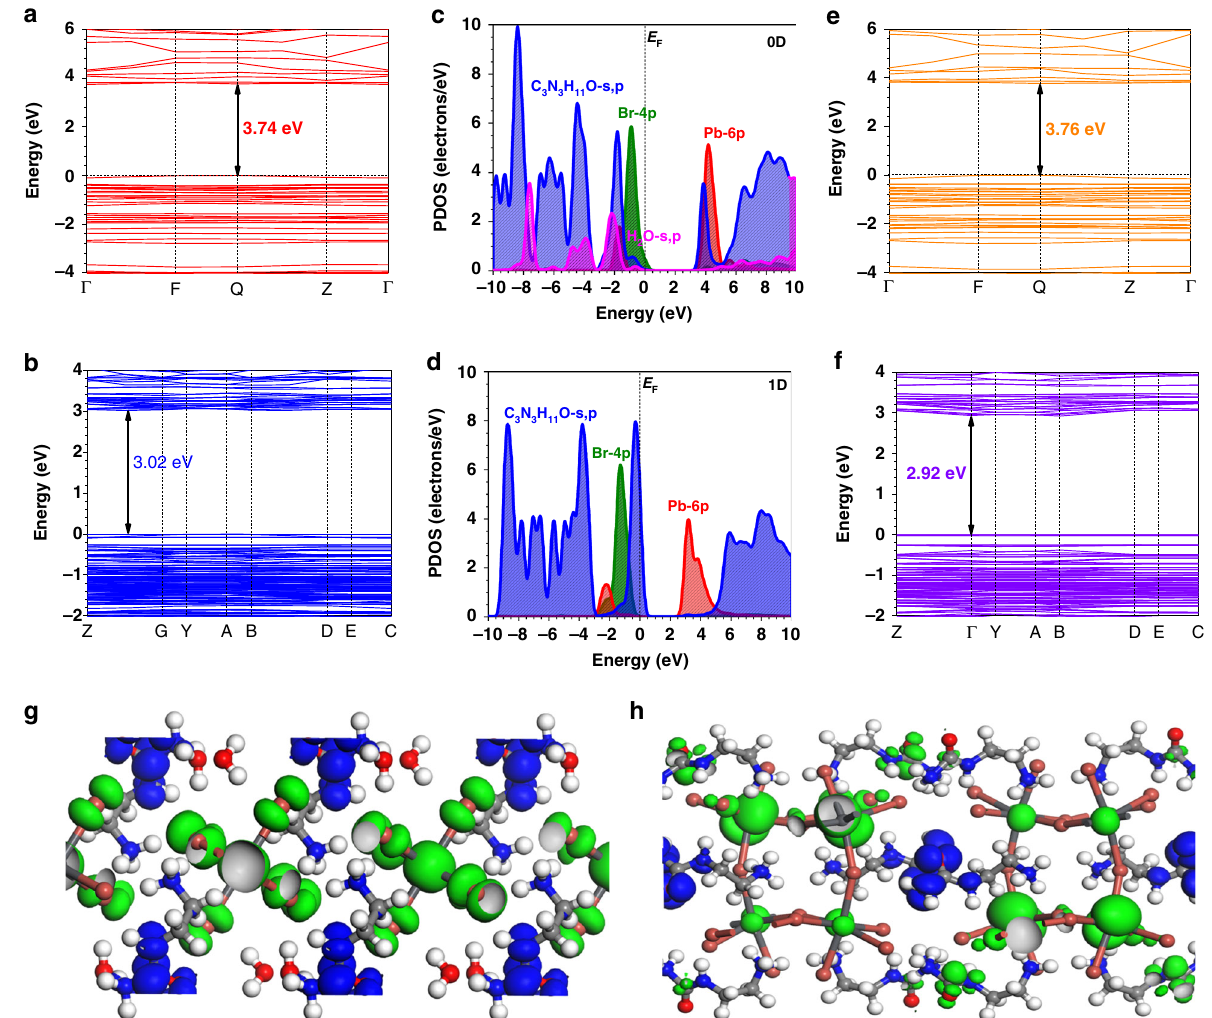
Fig. 4 Density functional theory (DFT) calculations on band structures and photoluminescence mechanisms. a , b Calculated band structure of 0D and 1D lead bromide hybrids under ultrasoft pseudopotential. Inset: Zoom-in valence band (VB) structure. c , d Projected density of states of 0D and 1D lead bromide hybrids, respectively. e , f Calculated band structure of 0D and 1D lead bromide hybrids under norm conserving pseudopotential. Inset: Zoom-in valence band (VB) structure. g , h Real spatial contour plots for bonding and anti-bonding orbitals near E F for 0D and 1D lead bromide hybrids,